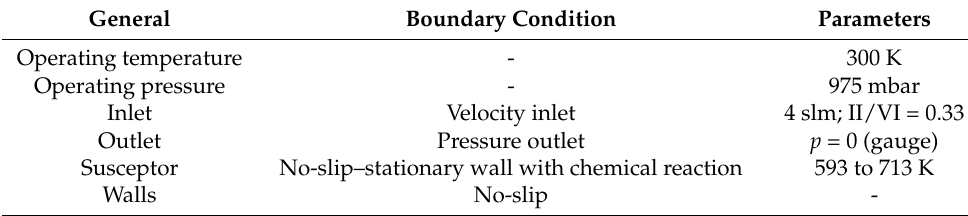
Table 1. The detailed boundary